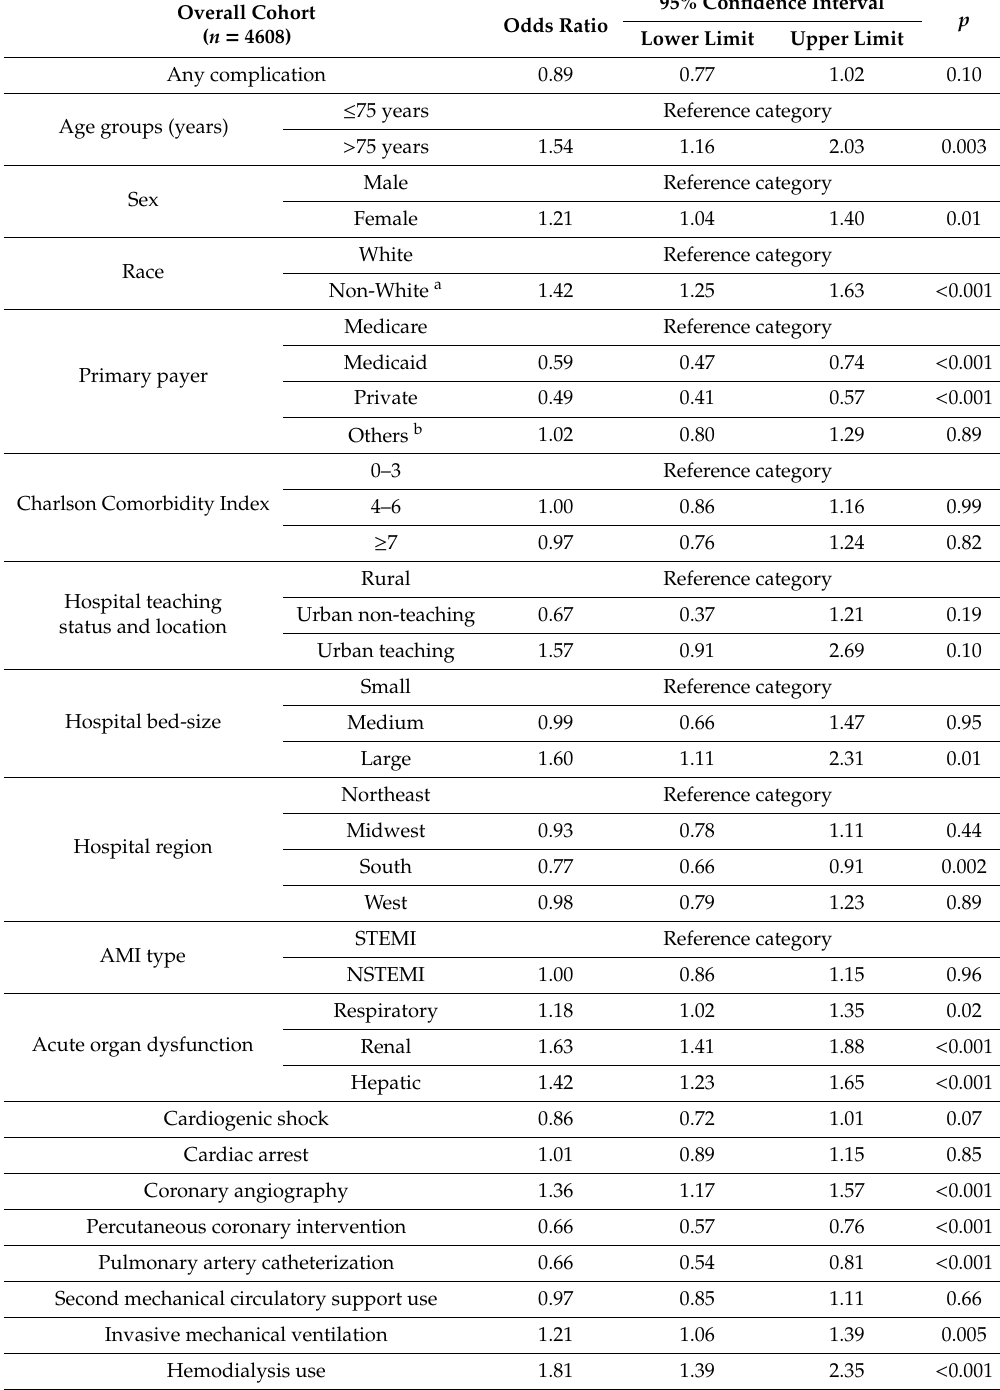
Table 1. Predictors of in-hospital